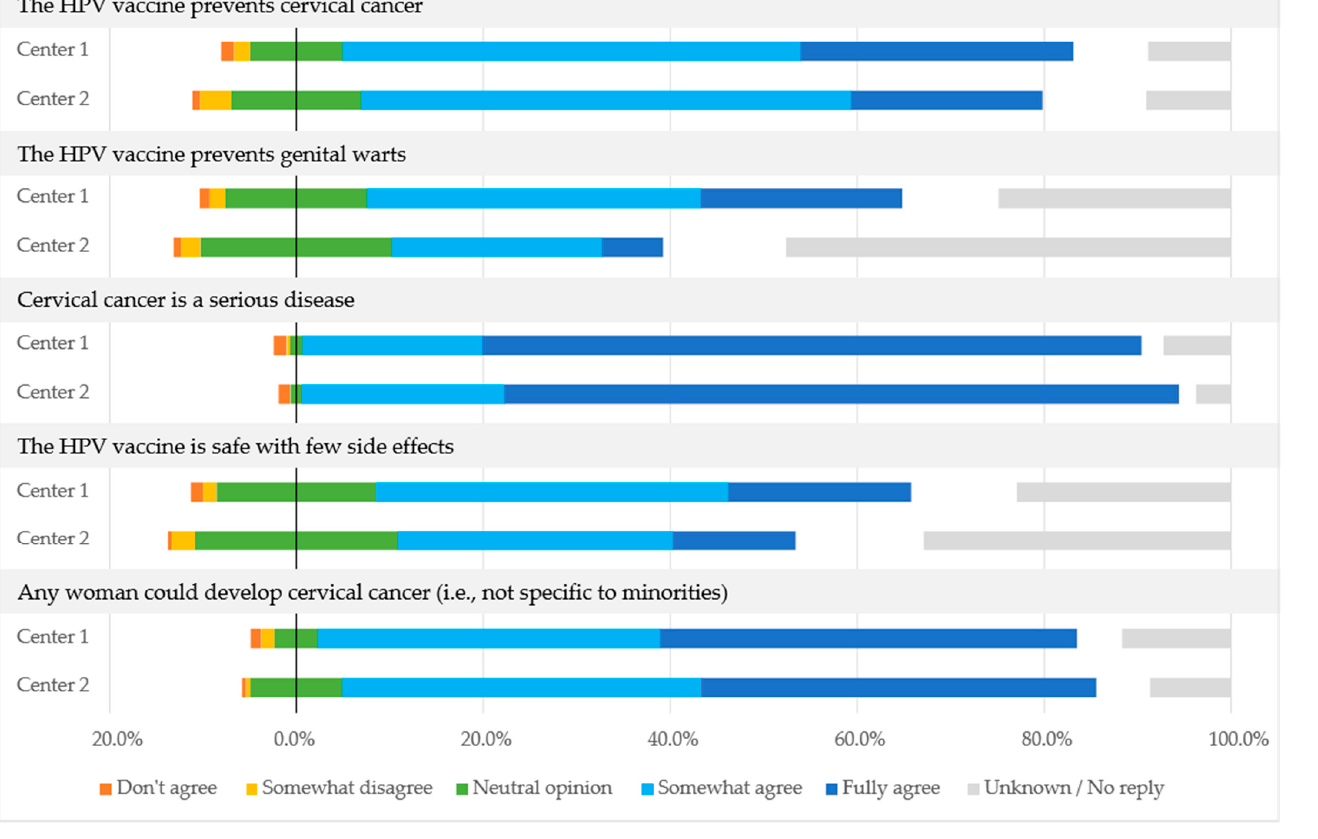
Figure 1. Level of agreement with the statements about the HPV vaccine and HPV-related diseases at Center 1 and Center 2, expressed as a proportion of all participants at each center.